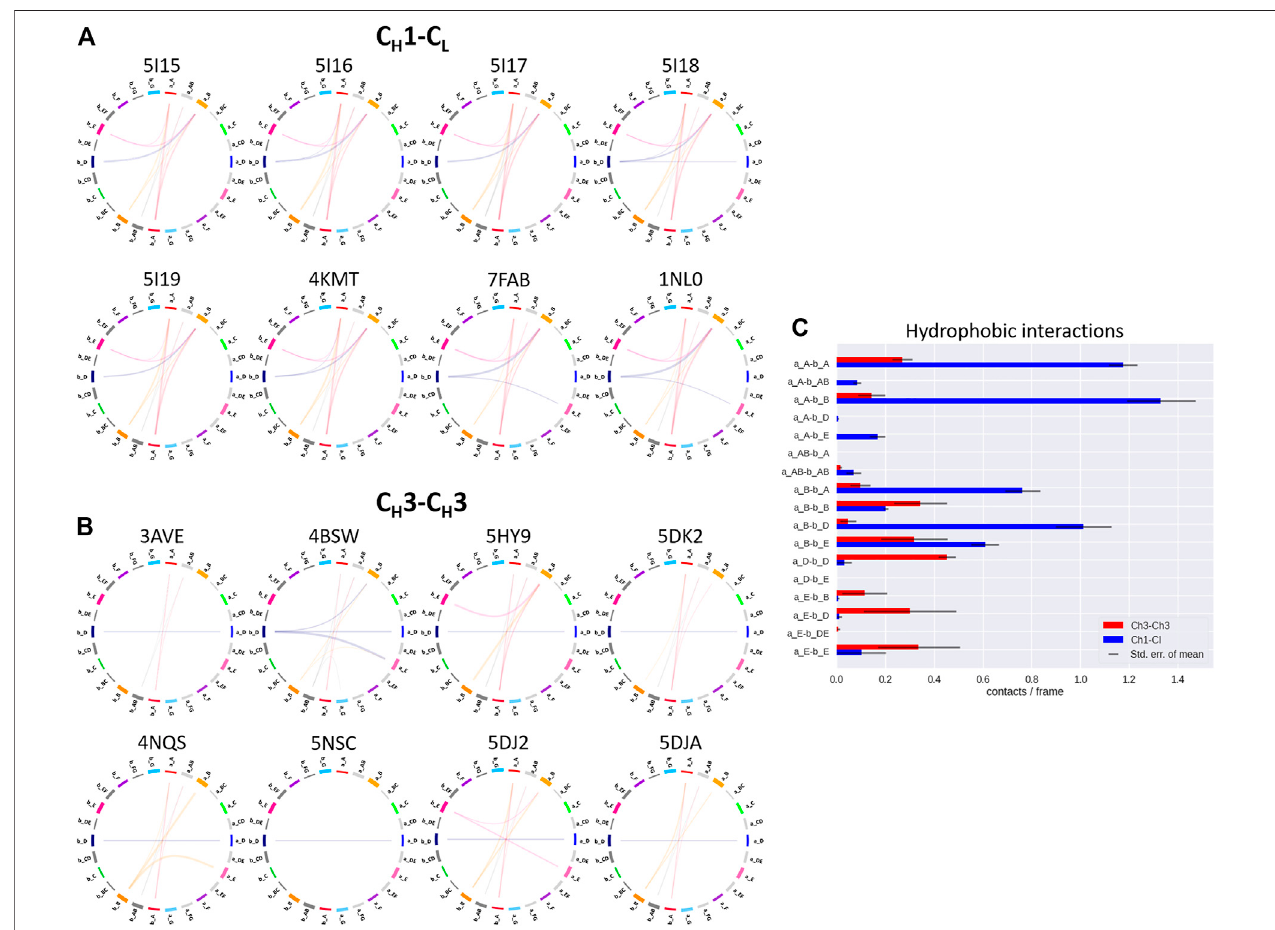
FIGURE 5 | Exemplary coarse-grained fl areplots showing the hydrophobic interactions formed between the different interdomain β -strands and loops of both (A) C